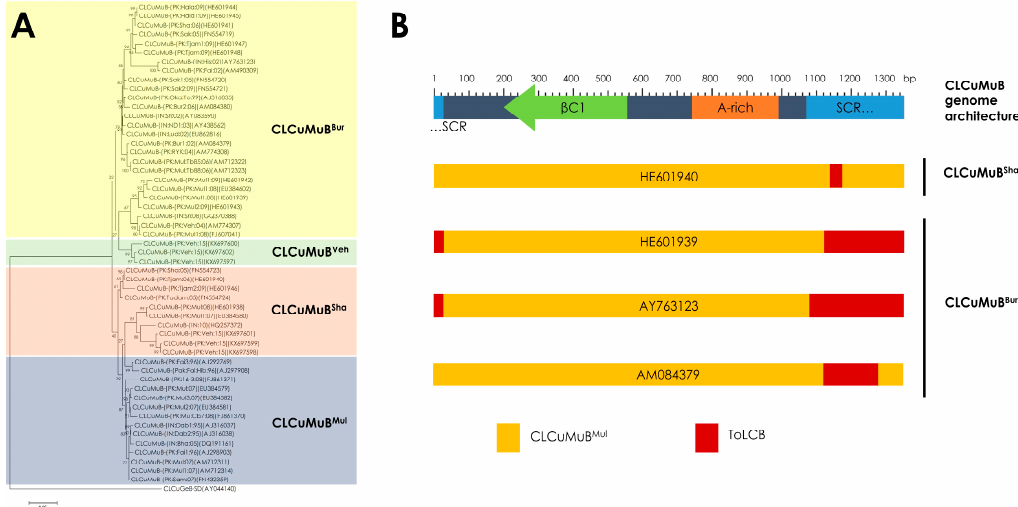
Figure 3. Phylogeny and recombination of Cotton leaf curl Multan Betasatellite (CLCuMuB). ( A